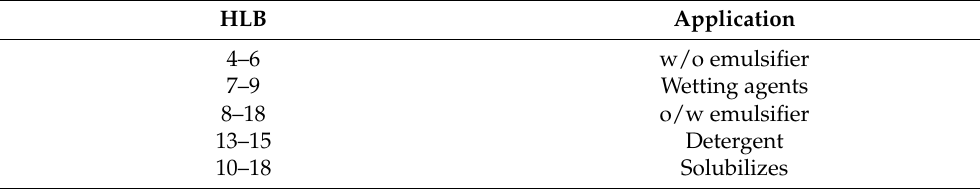
Table 11. Application of surfactants depends upon the HLB value.